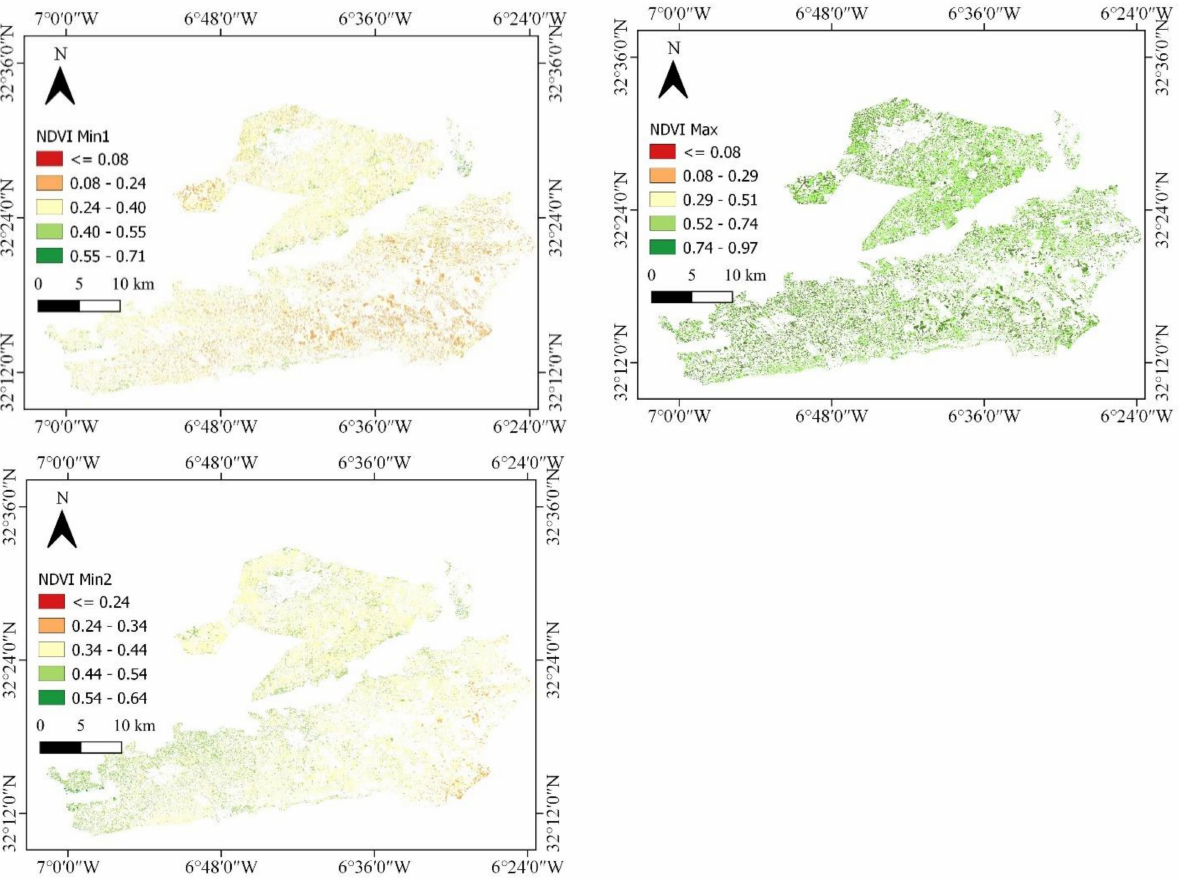
Figure 12. NDVI Min1 , NDVI Max , and NDVI Min2 for the TIP